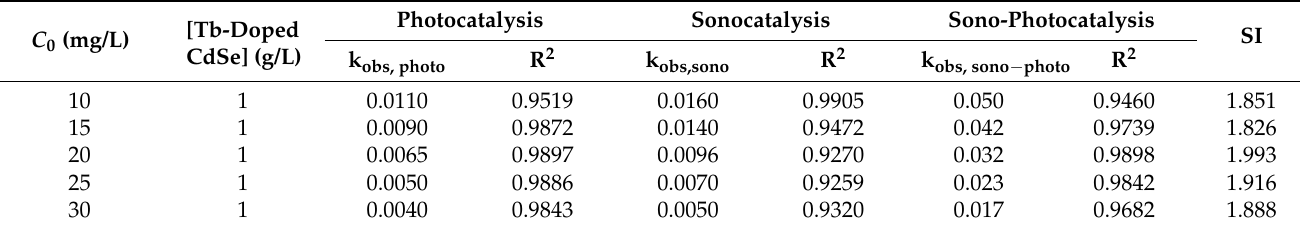
Table 5. Pseudo-first-order kinetic constants for sonocatalysis, photocatalysis, and sono-photocatalysis.